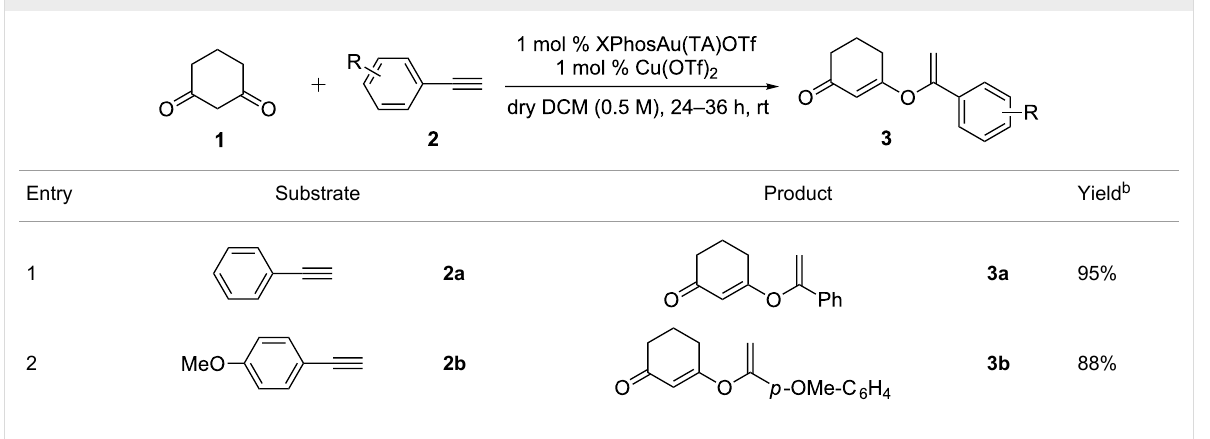
Table 2: Reaction scope of alkynes.